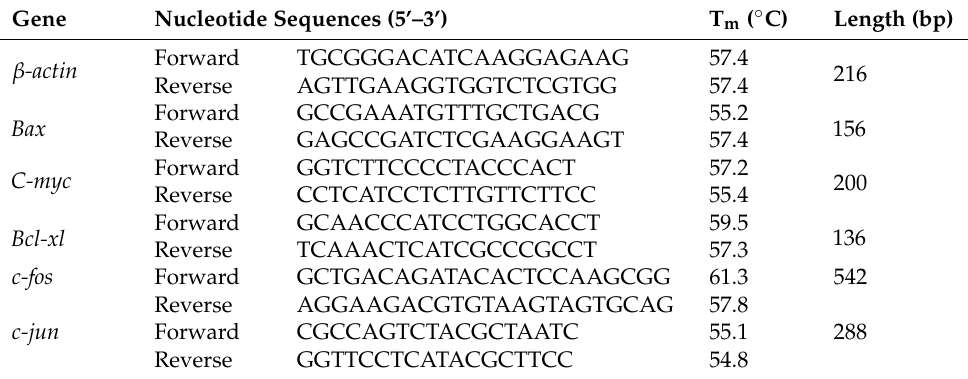
Table 1. Primer sequences for